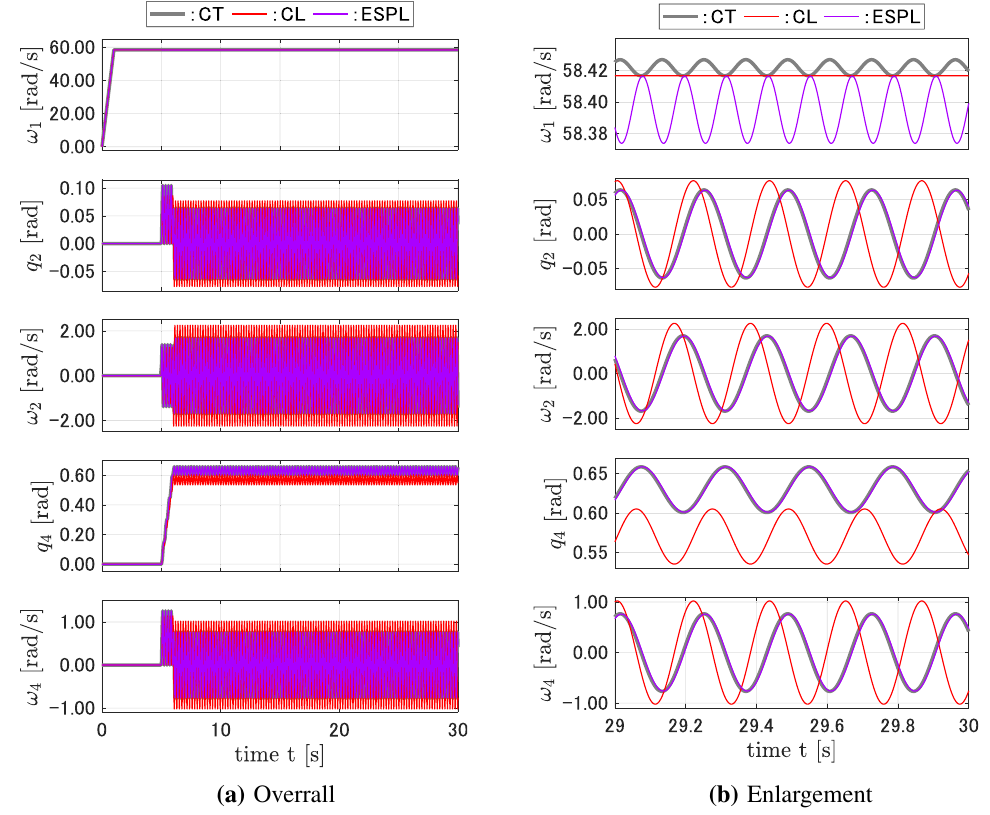
Figure 8. Responses of the CT, CL, and ESPL models for the equilibrium point with